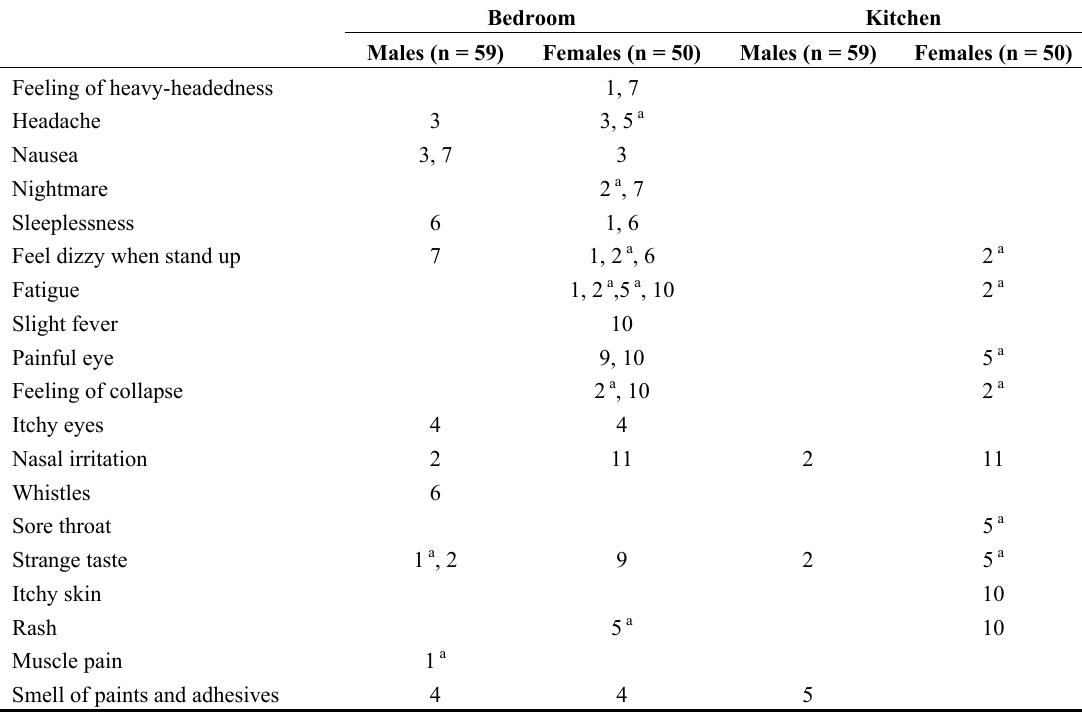
Table 5. Symptoms experienced after residents moved into their flats (shown by code in Table